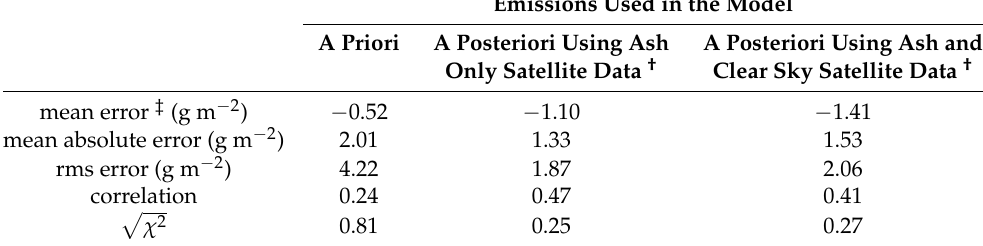
Table 1. Statistical comparison between modelled column loads and satellite ash retrievals for the Eyjafjallajökull 2010 eruption at the locations of the 40,728 ash-only retrievals * made up to 29 May 2010 23:00 UTC. Emissions Used in the Model A Priori A Posteriori Using Ash A Posteriori Using Ash and Only Satellite Data † Clear Sky Satellite Data † mean error ‡ (g m − 2 ) − 0.52 − 1.10 − 1.41 mean absolute error (g m − 2 ) 2.01 1.33 1.53 rms error (g m − 2 ) 4.22 1.87 2.06 correlation 0.24 0.47 0.41 (cid:112) χ 2 0.81 0.25